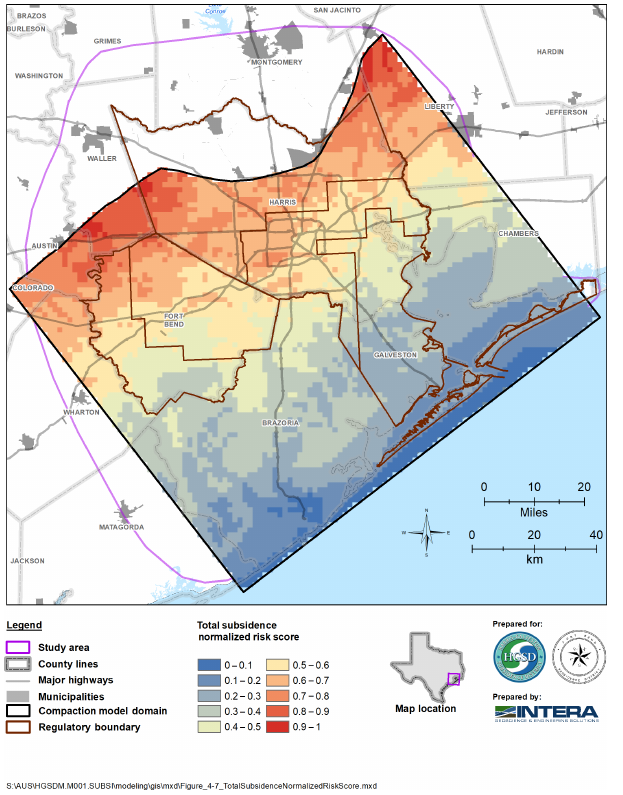
Figure 3. Total subsidence normalized risk score in the Jasper aquifer, Gulf Coast Aquifer system, near Houston, TX,